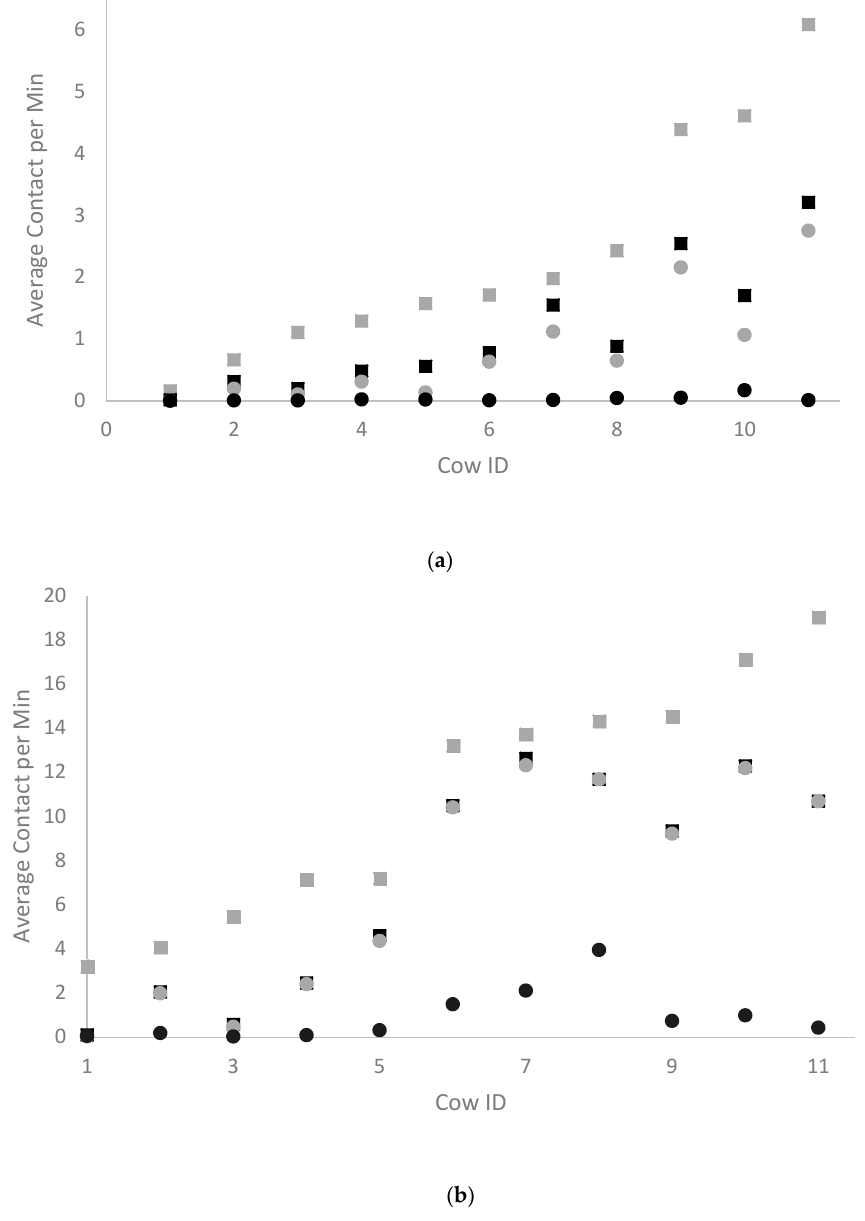
Figure 3. Plot of the average number of contacts per minute made by each cow ( n = 11) with ( a ) the neck rail, or ( b ) dividers as recorded by the CM system (black circles) compared to video observation (Rail Contact: grey squares; CM Contact: black squares; Effective CM Contact: grey circles).